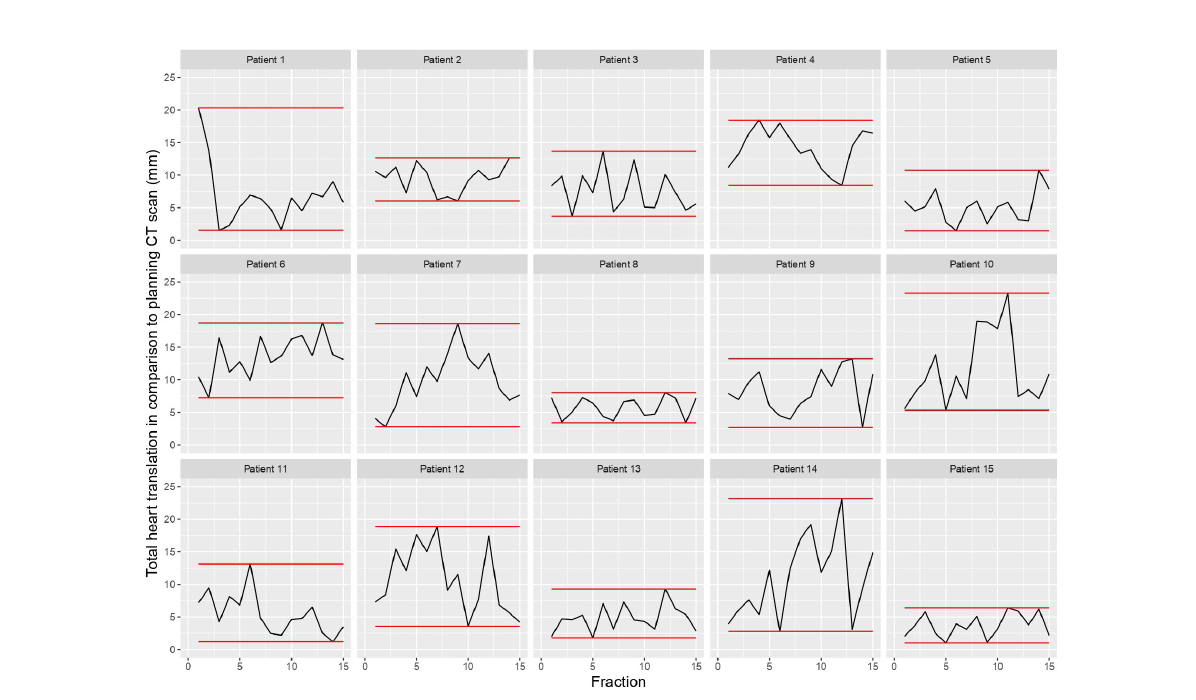
FIGURE 2 Individual 3D heart translation per patient (n = 15) in comparison to the planning CT scan, with the minimal and maximal translation (red